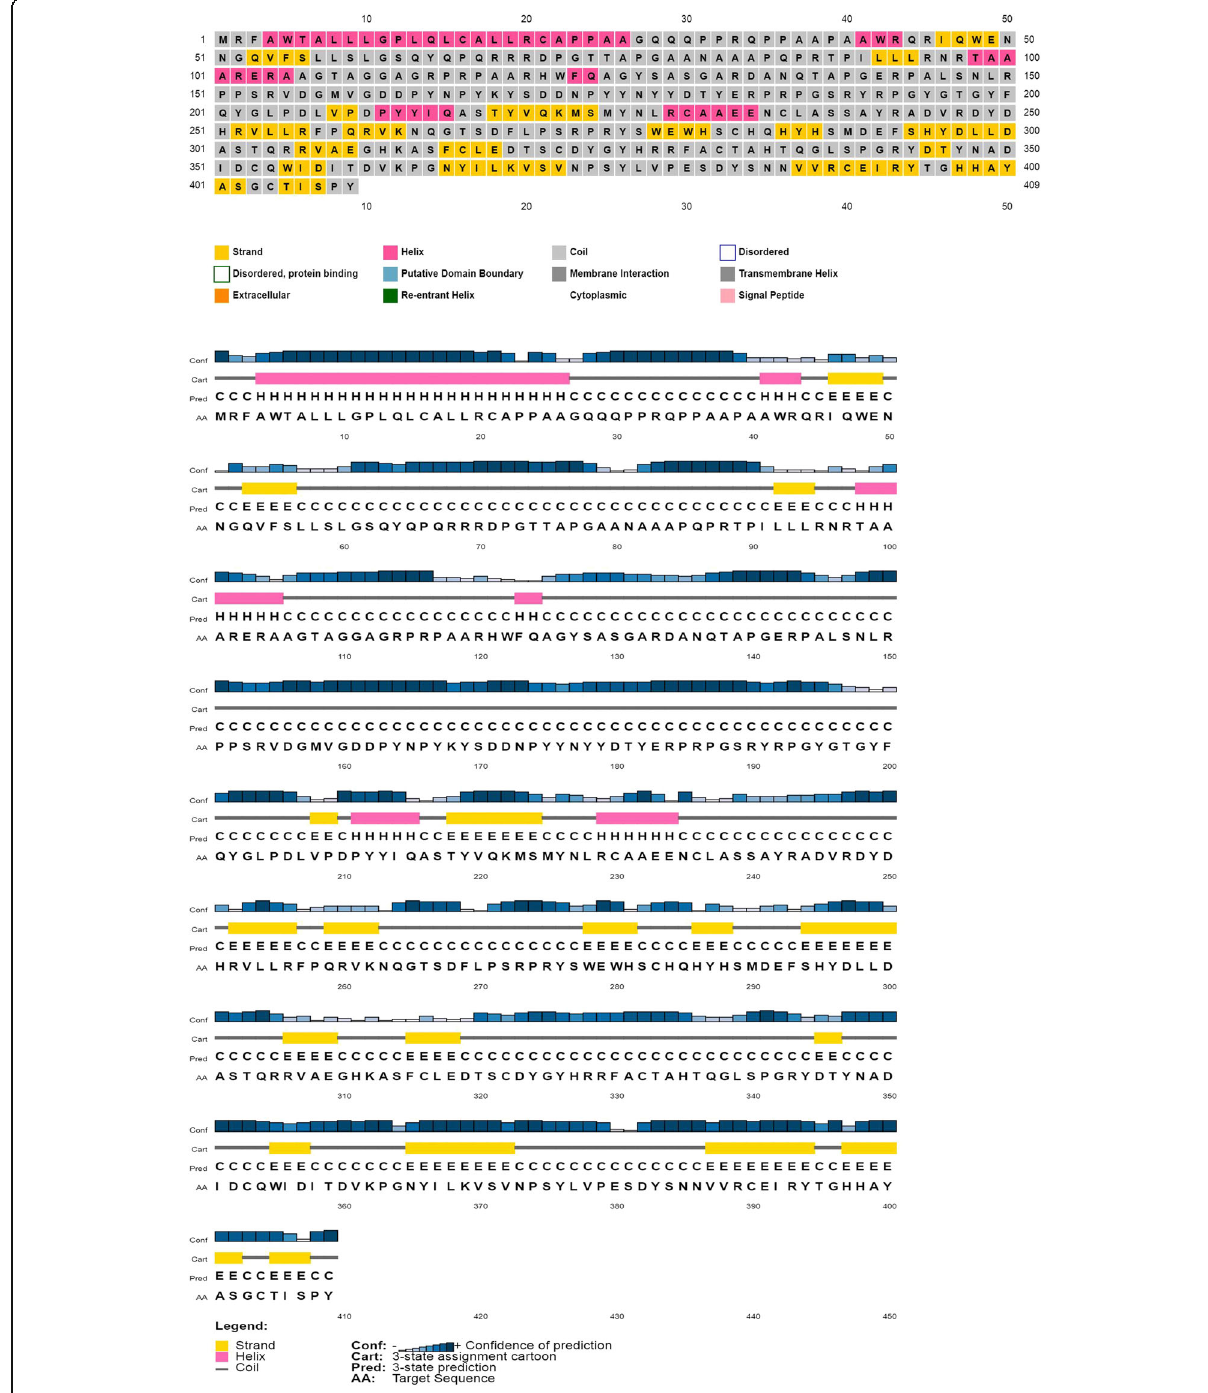
Fig. 2 Secondary structure prediction using PSIPRED. Eight percent of total amino acids contributed to helix, 73% to coils, and 18% to strands. Thus, coil dominates the secondary structure elements followed by alpha